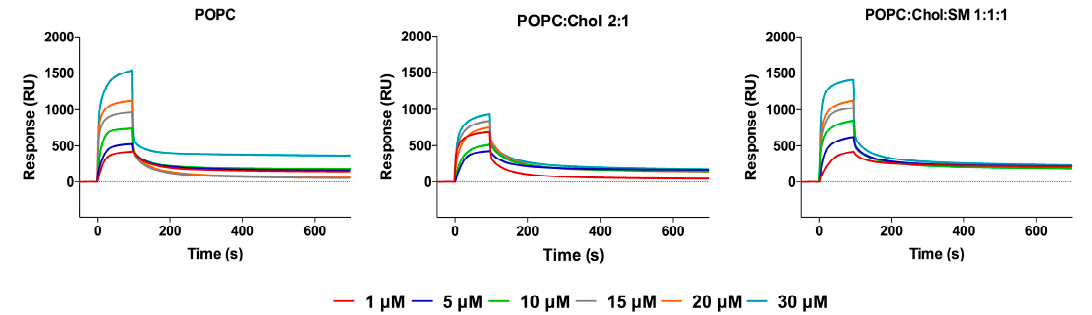
Figure 2. Evaluation of MV–HC peptide interaction with membranes. SPR sensorgrams obtained for MV–HC in the presence of POPC, POPC:Chol = 2:1 or POPC:Chol:SM = 1:1:1 membranes (1 mM). A range of peptide concentrations (1–30 µM) was injected over the deposited vesicles.